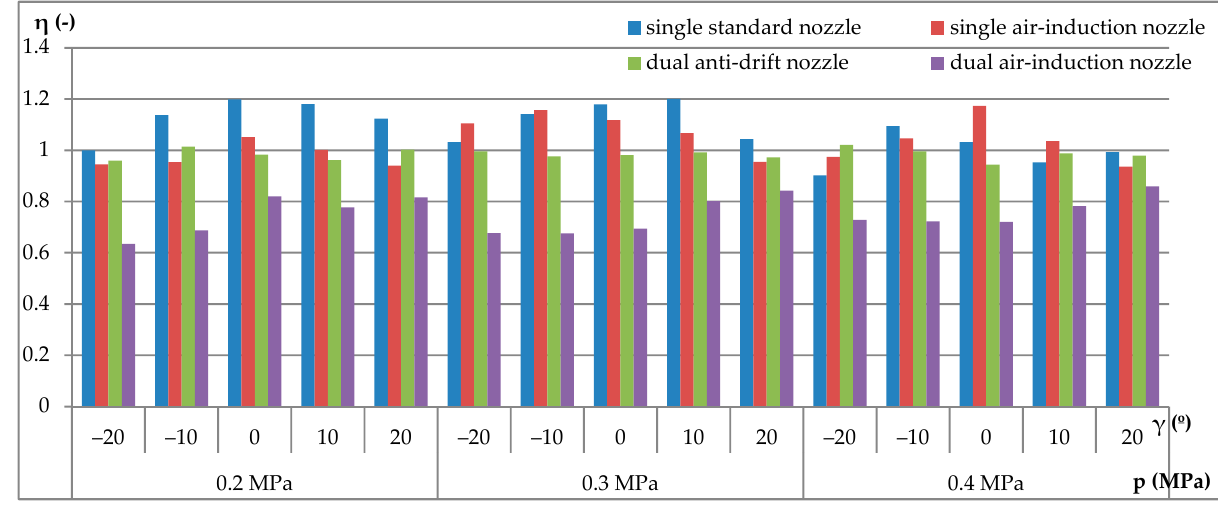
Figure 5. Coverage unevenness coefficient for selected nozzles at 1,1 m ∙ s − 1 driving speed.